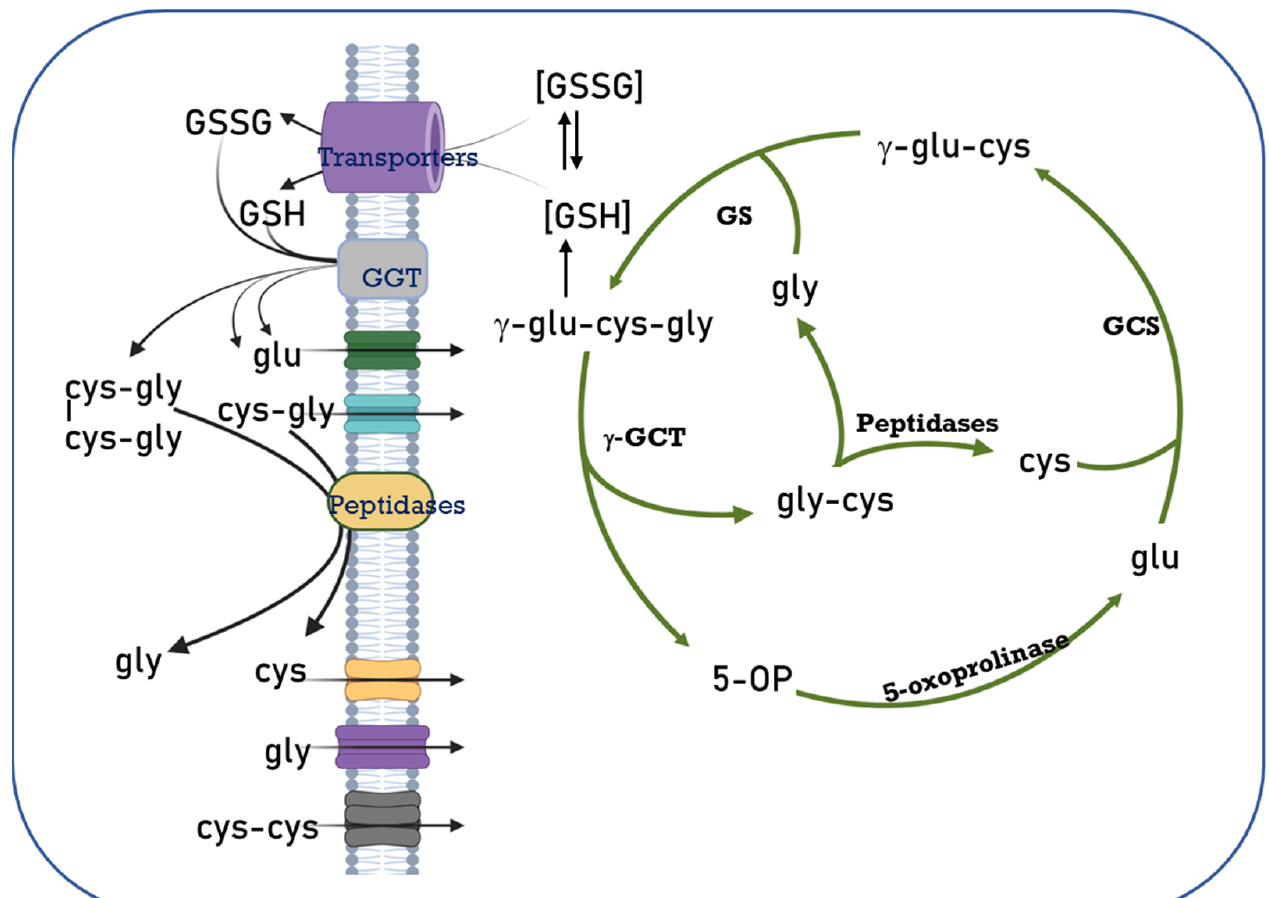
Figure 1. The Glutathione Cycle. Cellular glutathione homeostasis is directly related to its synthesis, degradation, transport, and the availability of the amino acids that make up the non-protein thiol. Different enzymes participate in this regulation process, such as γ -glutamylcysteine synthetase (GCS), glutathione synthetase (GS), 5-oxoprolinase, glutathione transporters, γ -glutamyl transpep- tidases (GGT), membrane peptidases and amino acid transporters. 5-OP: 5 oxoproline. Modified from [30] .